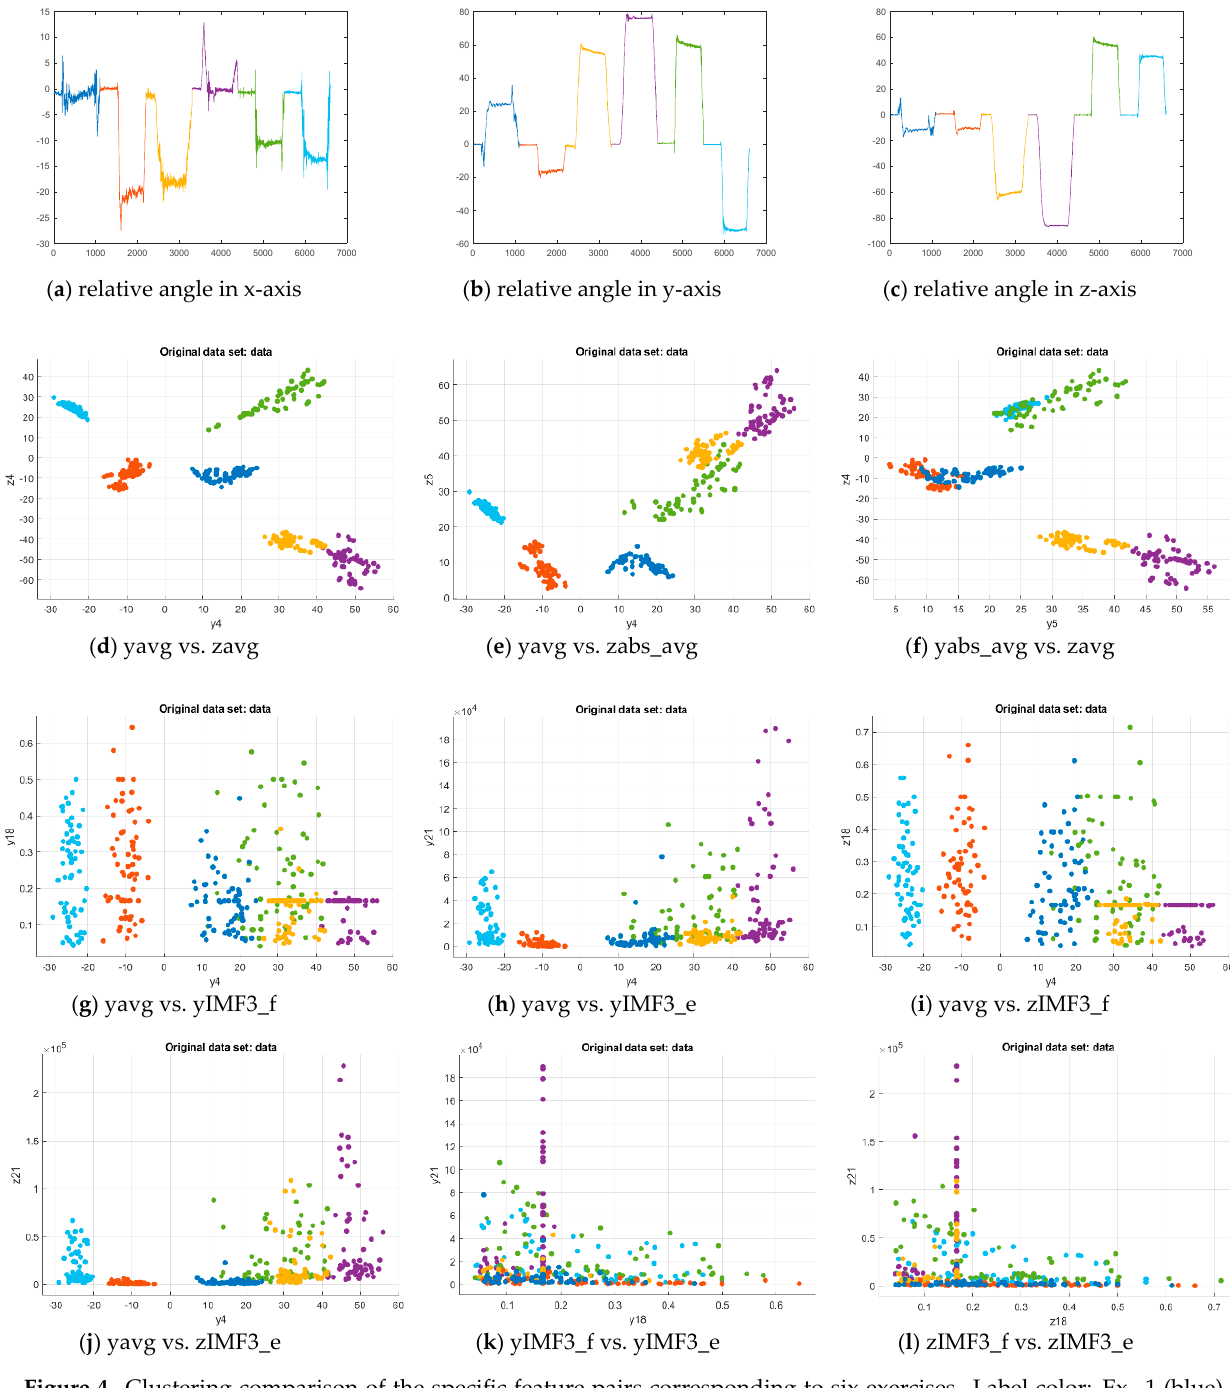
Figure 4. Clustering comparison of the specific feature pairs corresponding to six exercises. Label color: Ex. 1 (blue), Ex. 2 (red), Ex. 3 (yellow), Ex. 4 (purple), Ex. 5 (green), Ex. 6 (cyan) Table 5. Definition of the feature patterns and accuracies of the trained models with five-fold cross-validation Pattern ID Feature Set FEATURE SYMBOL ML Model 1